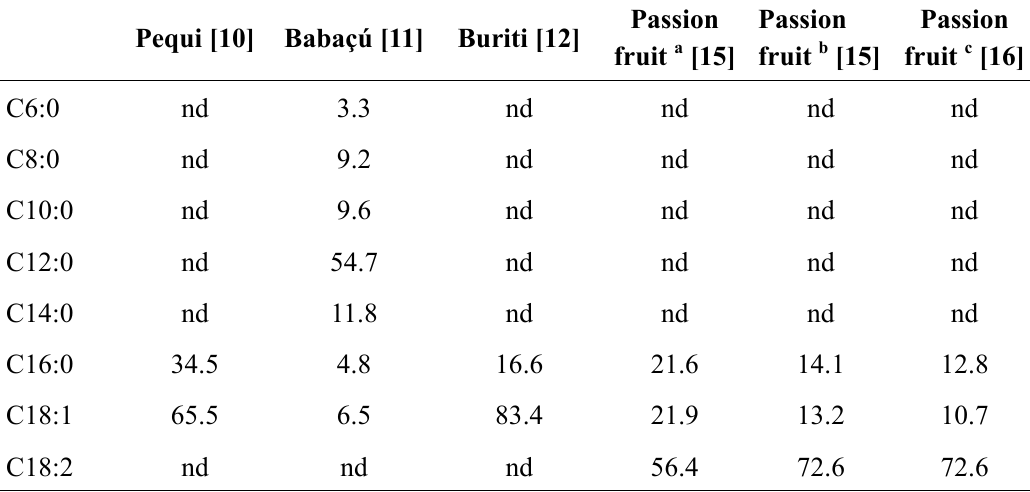
Table 2. Fatty acids composition (mean percentage) of Amazonian vegetable